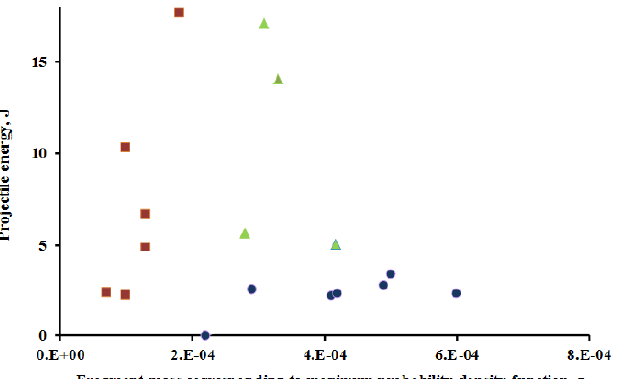
Figure 7: The dependence of fragment mass corresponding to maximum probability density function on the projectile energy.